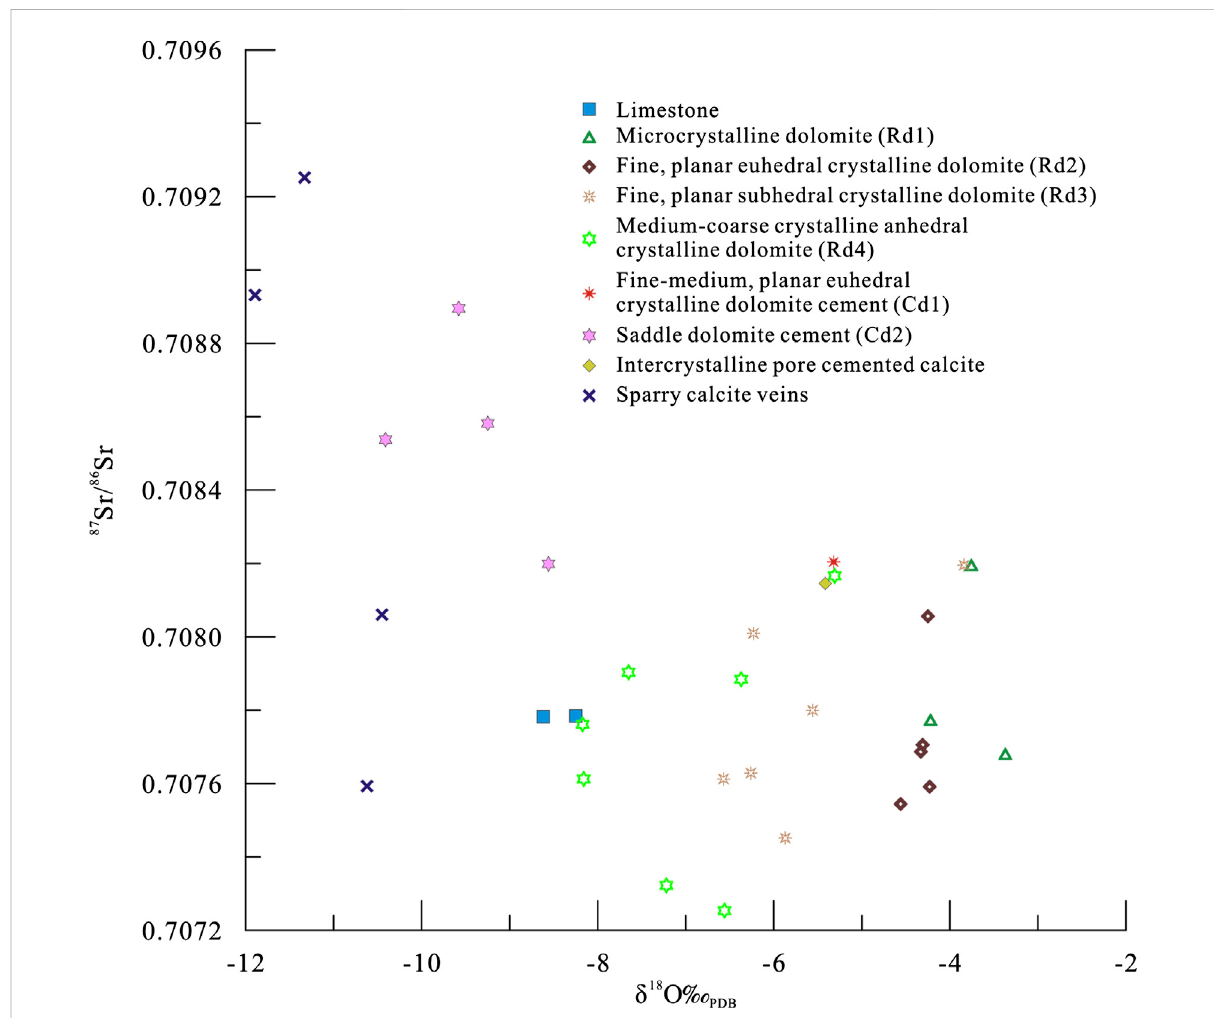
FIGURE 8 Cross-plot showing δ 18 O vs. δ 13 C for different carbonate rocks in the study